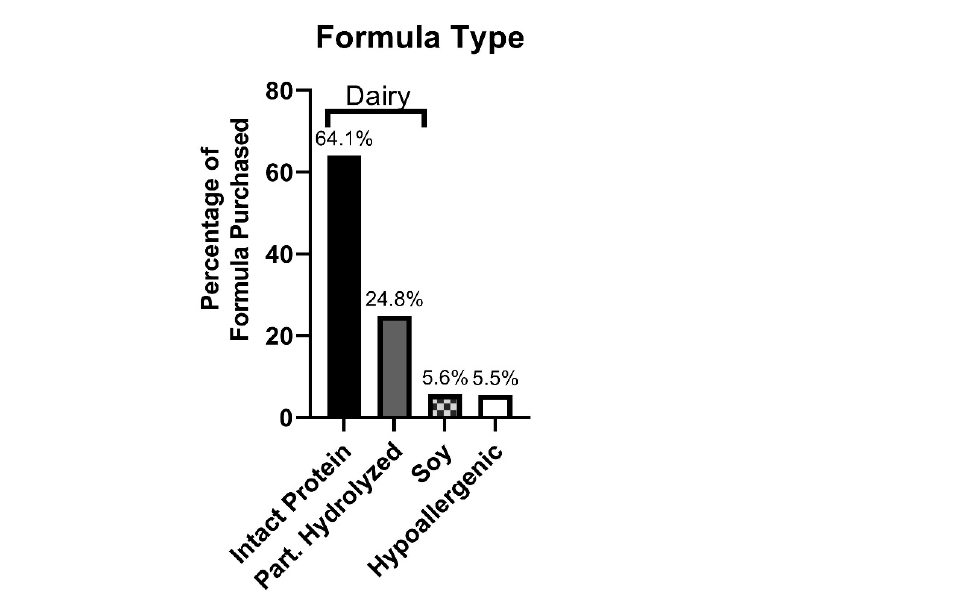
Figure 1. Types of infant formula purchased in the US between 2017–2019.